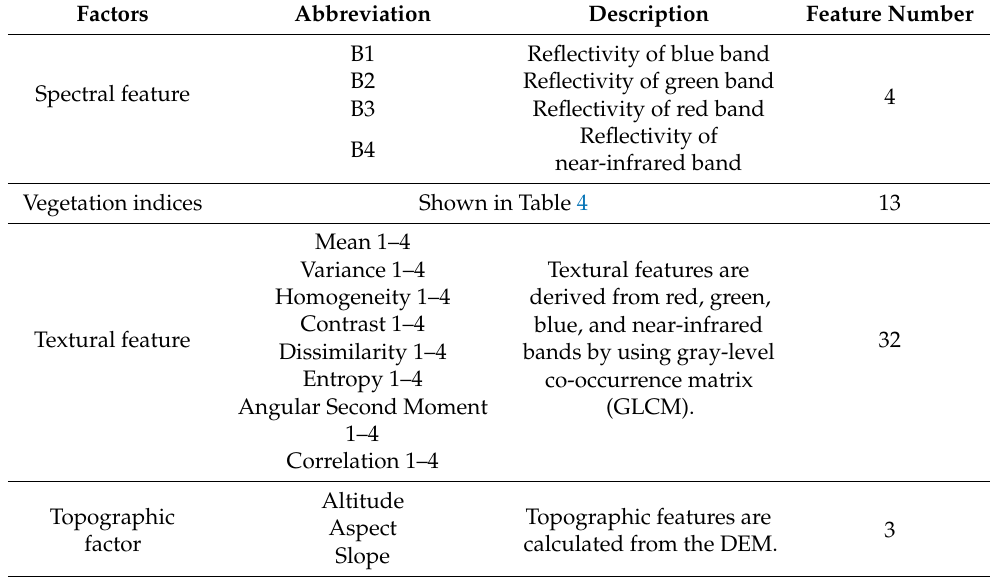
Table 3. Description of